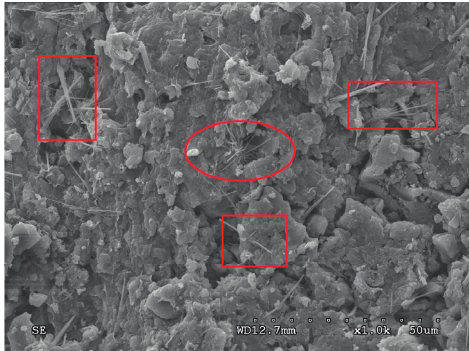
Figure 10: The soil of curing 28d and being magnified 1000